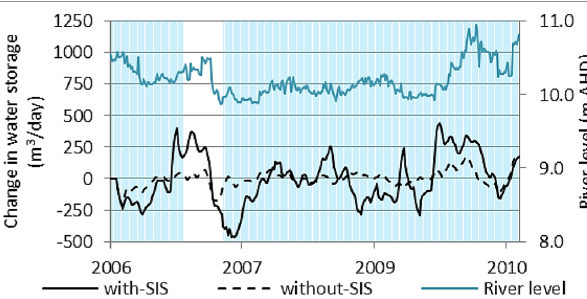
Fig. 7. Groundwater heads at the boundary of the models (SIS wells) for the defined scenarios.